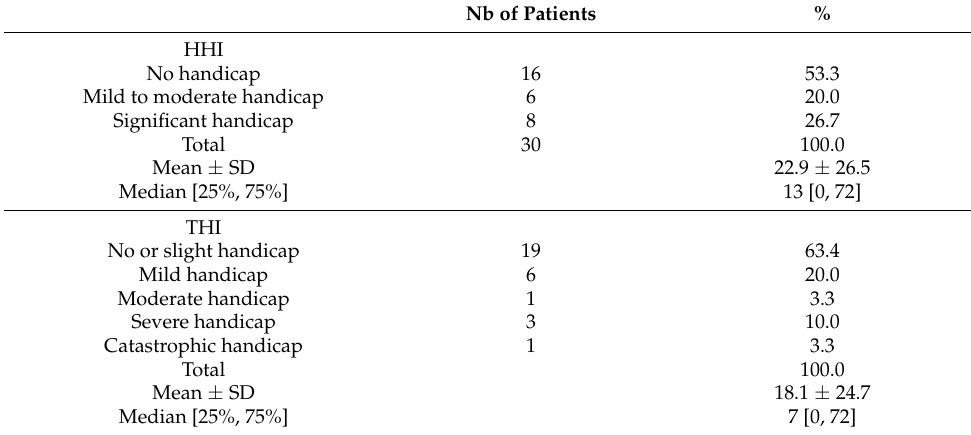
Table 3. Number of patients (Nb, %), mean and median scores (SD, standard deviation) for each of the Hearing Handicap Inventory (HHI), Tinnitus Handicap Inventory (THI) and Dizziness Handicap Inventory (DHI) questionnaires at long-term follow-up after temporal bone